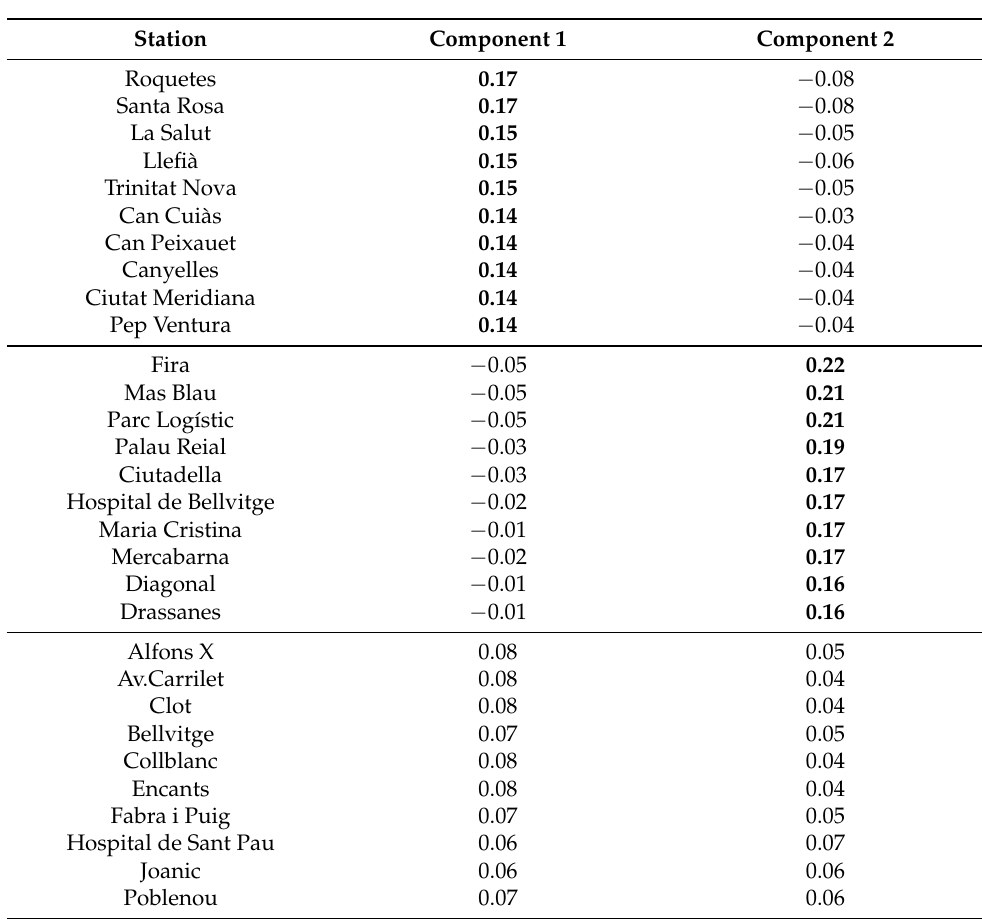
Table 6. Component matrix A for selected